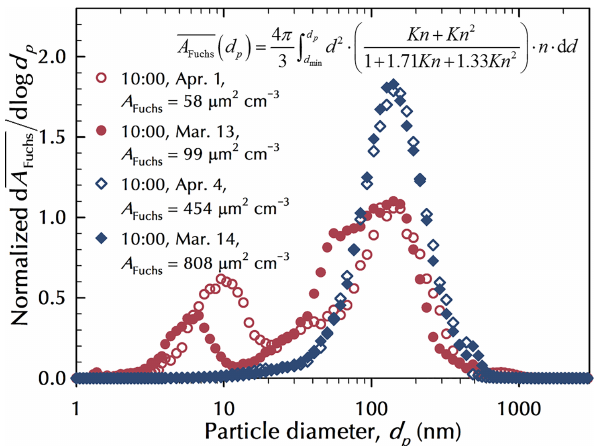
Figure 10. Normalized distribution of cumulative Fuchs surface area, A Fuchs , as a function of the particle diameter, d p , on 2 NPF days (red circle) and 2 non-event days (blue diamond). A Fuchs is equal to A Fuchs when d p approaches positive infinity. d A Fuchs / dlog d p is normalized by A Fuchs